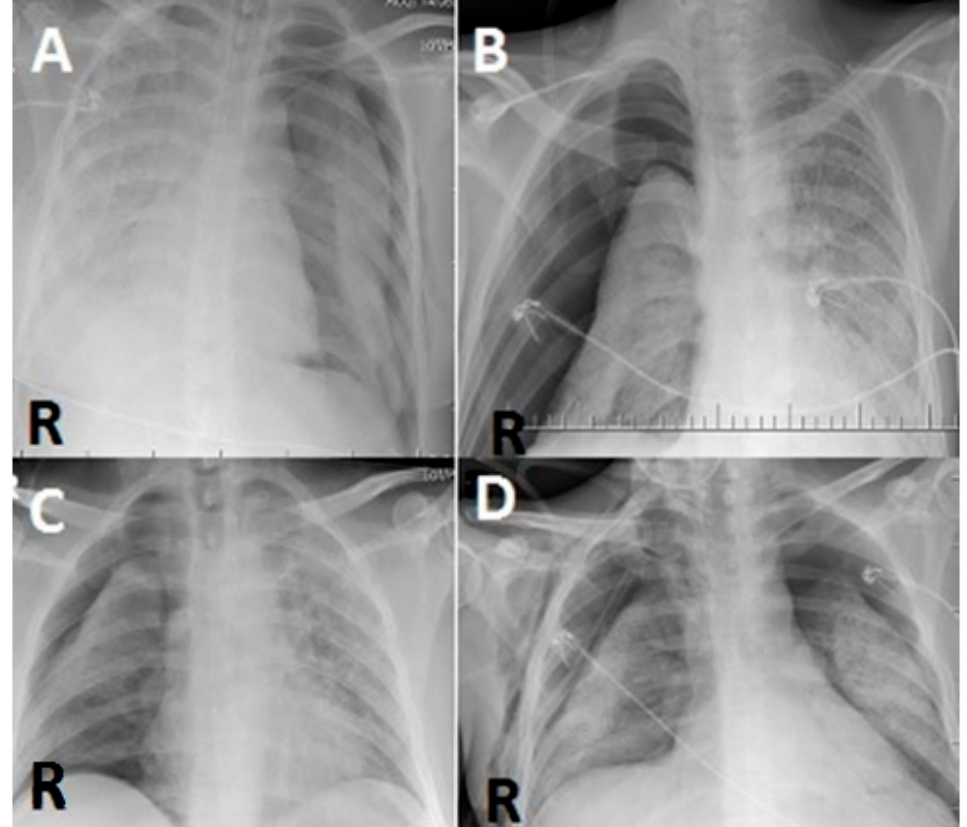
Figure 2. ( A ) In a posterior–anterior lung roentgenogram, the right lung is almost completely radiopaque, while PNX is seen on the left side. ( B , C ) In a posterior–anterior lung roentgenogram, the left lung is almost completely radiopaque, while PNX is seen on the right side. ( D ) Bilateral PNX is observed in aposterior–anterior lung roentgenogram (R: right).